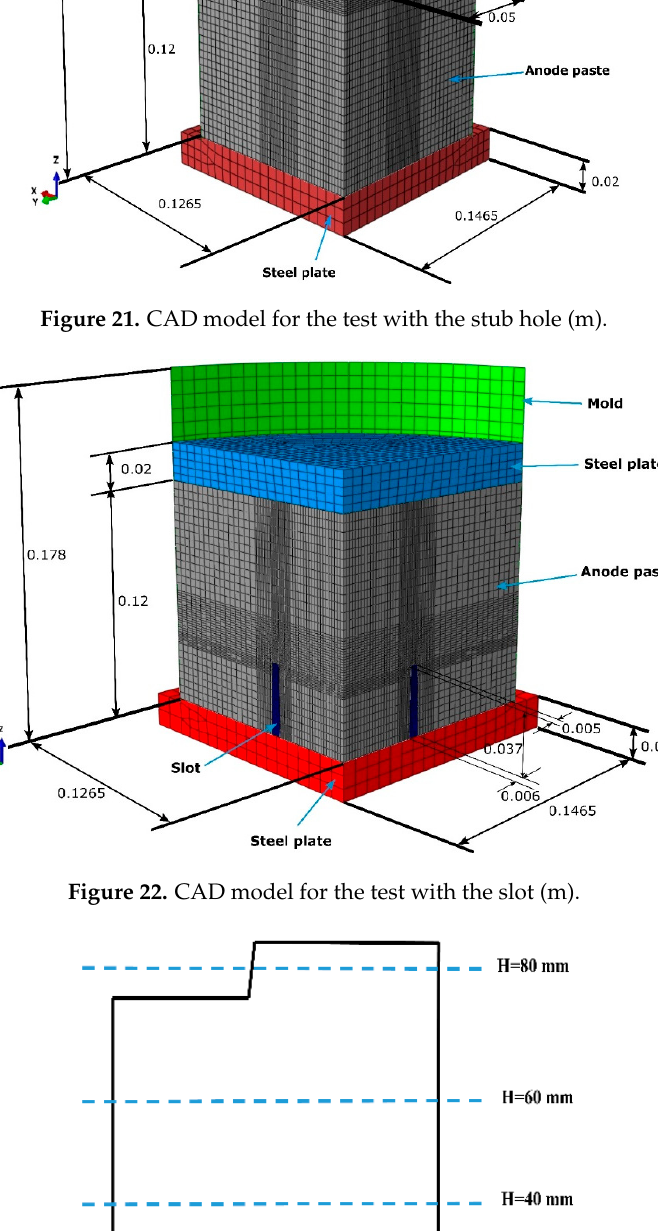
Figure 23. The deformed mesh of the compaction test with the stub hole.